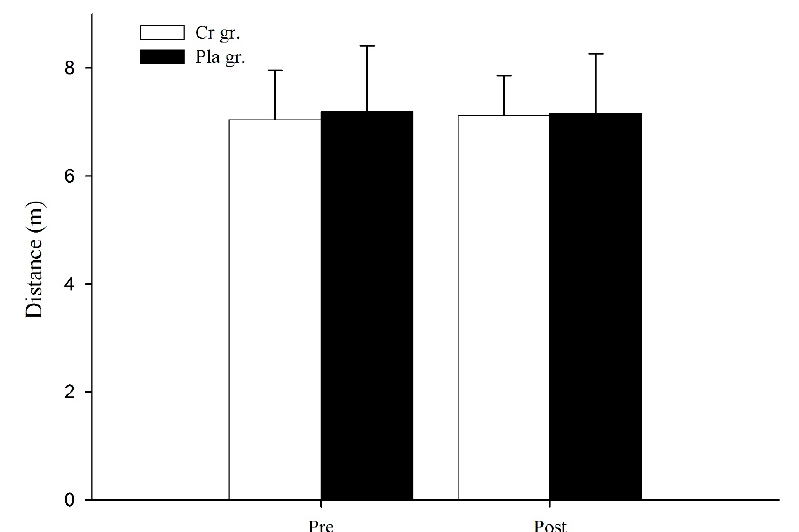
Figure 2. Distance of overhead medicine ball throw after the optimal individual post-activation potentiation (PAP) time in complex training bouts before and after six days of creatine or placebo supplementation. Data are the means ± standard deviation. Cr gr. = creatine group; Pla gr. = placebo group. Pre = pre-supplementation; Post = post-supplementation.